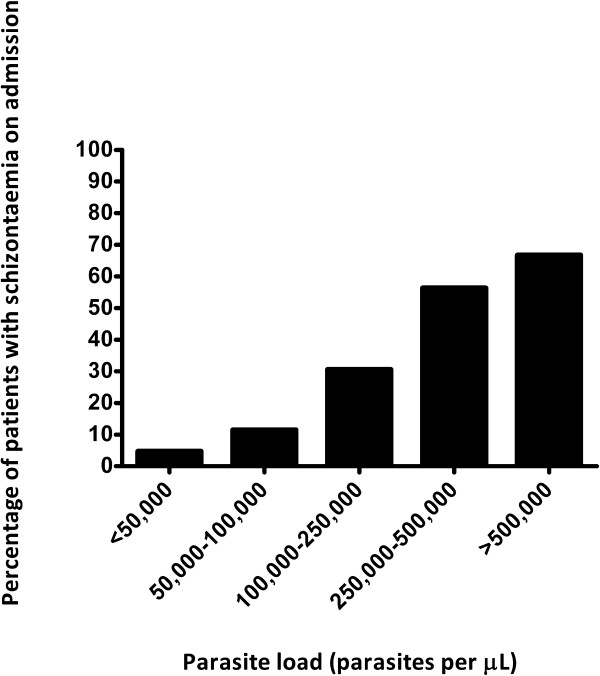
The percentage of patients with schizontaemia on admission, stratified by peripheral parasite count.